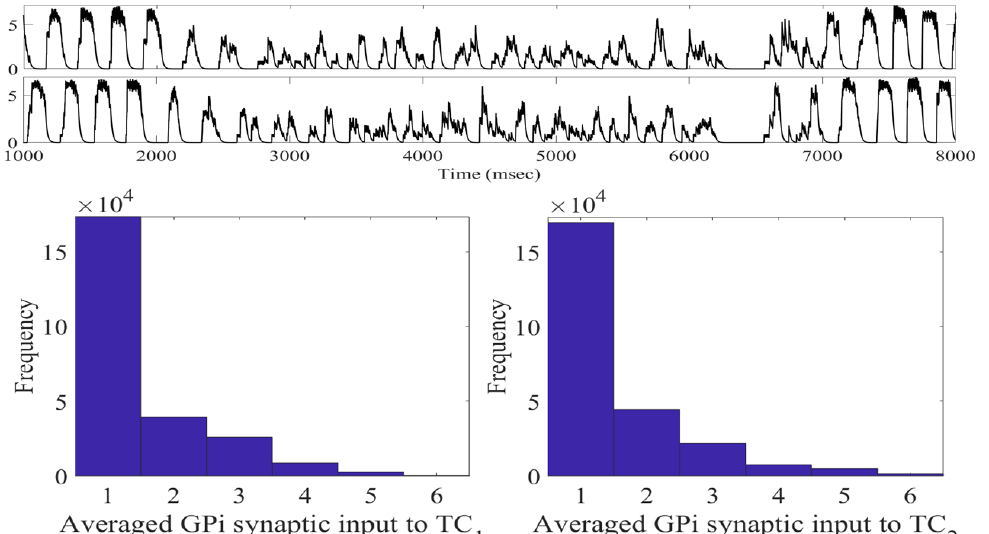
Figure 4. Total GPi synaptic inputs sg 1 and sg 2 ( top traces ) with corresponding histograms of sg ( left ) and sg ( right ) during the treatment window when acDBS was applied with a 0 = − 16 and 2 intt =